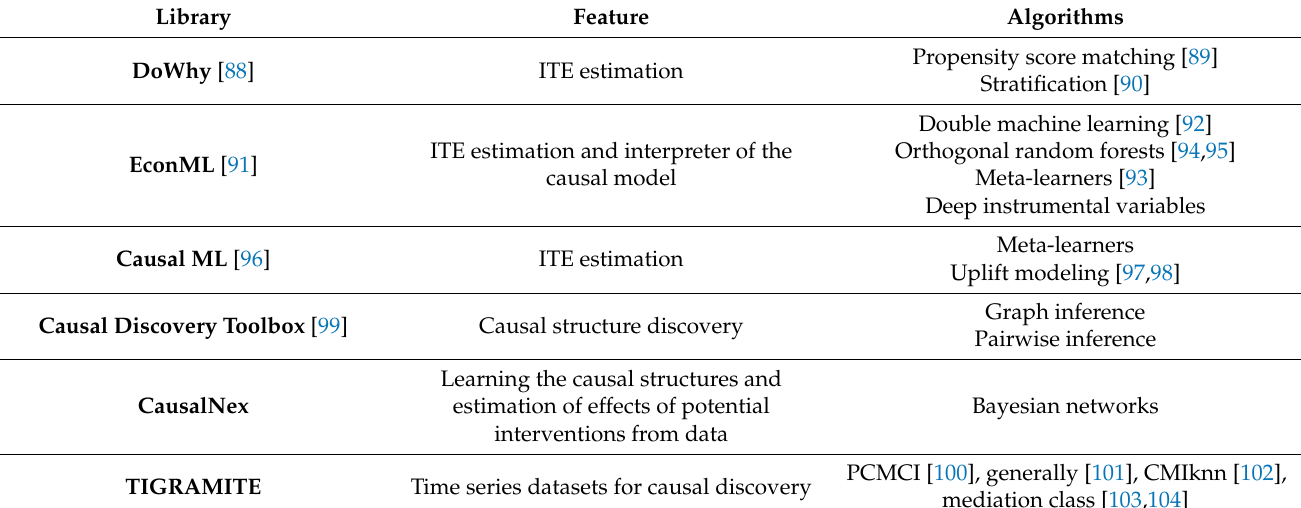
Table 4. Toolbox for causal analysis